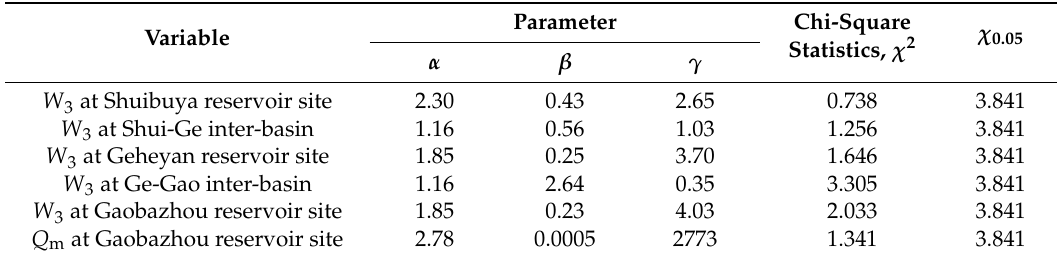
Table 2. Estimated parameters of the P3 marginal distribution for each region. Parameter Variable